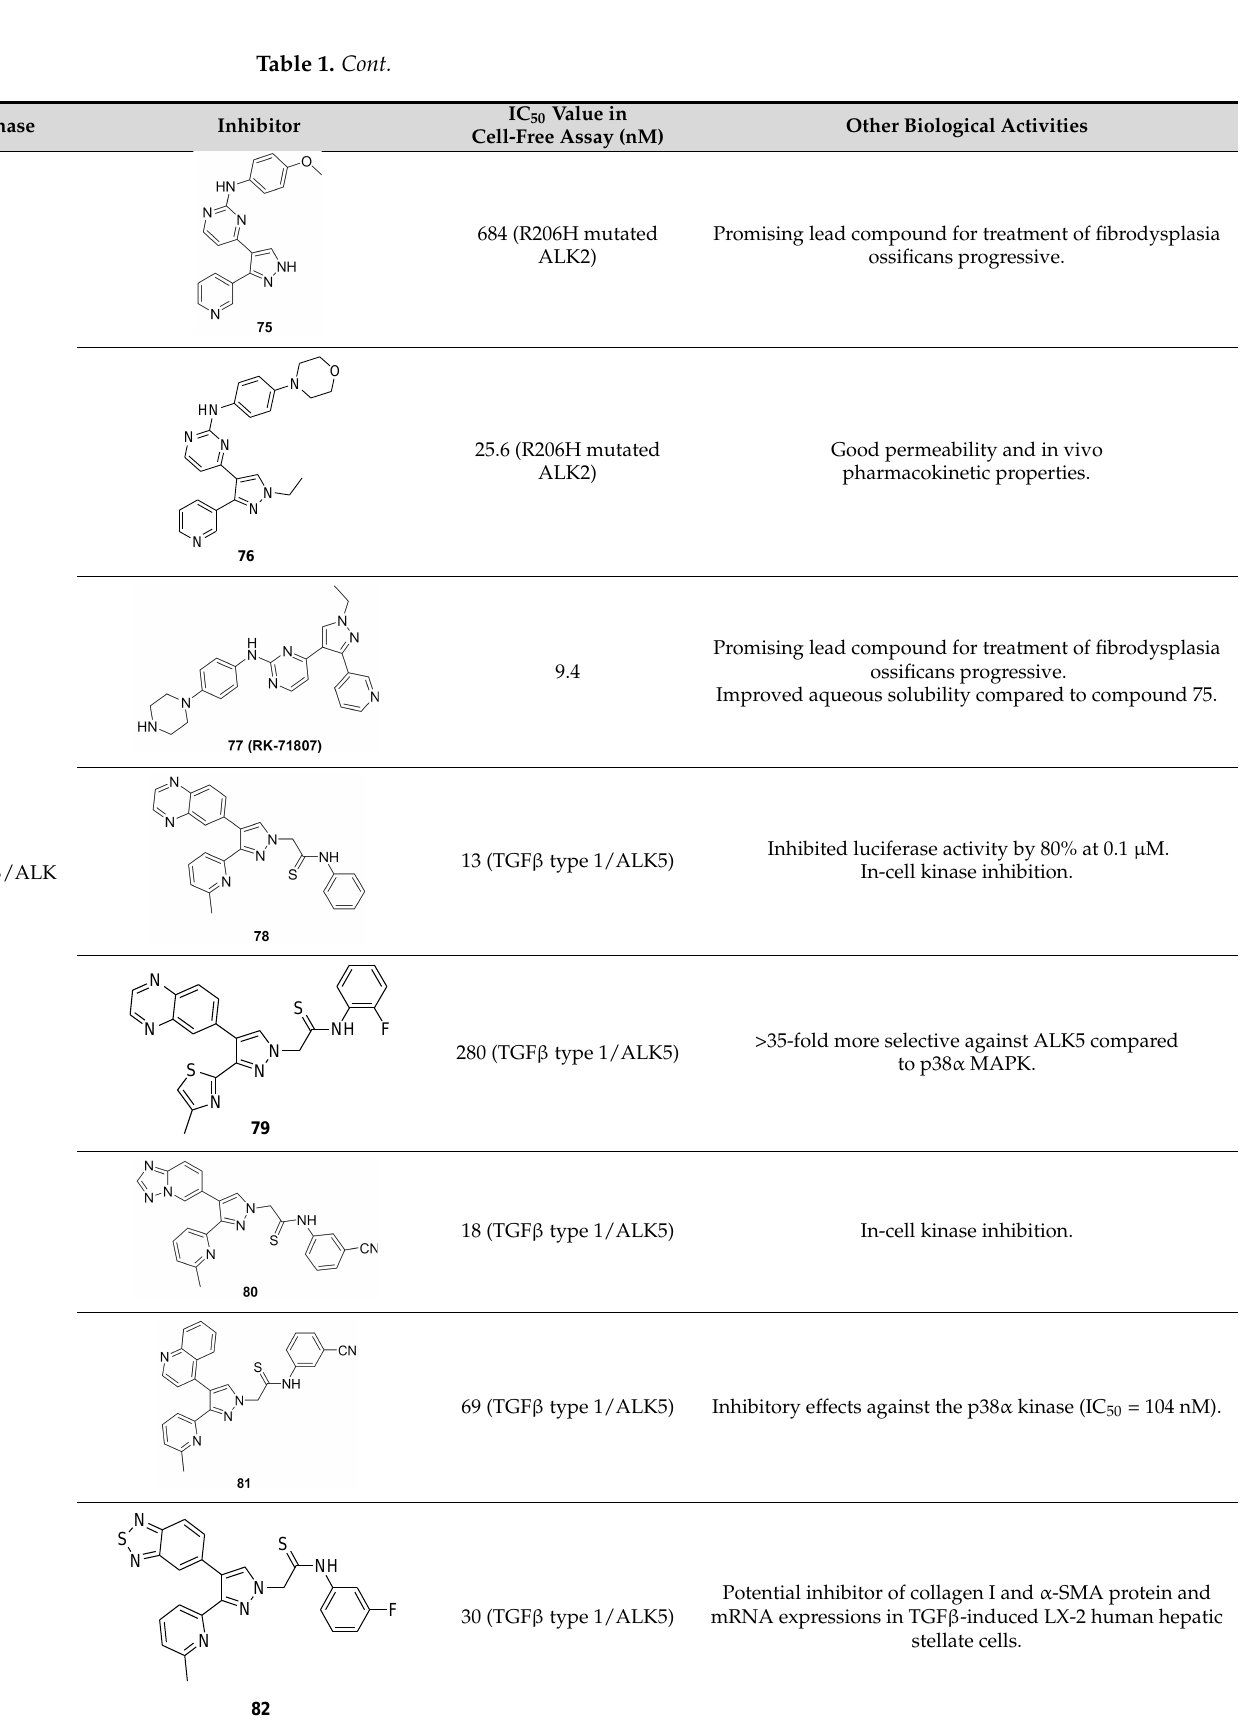
Potential inhibitor of collagen I and α -SMA p rotein and mRNA expressions in TGFβ -in- duced LX-2 human hepatic stellate